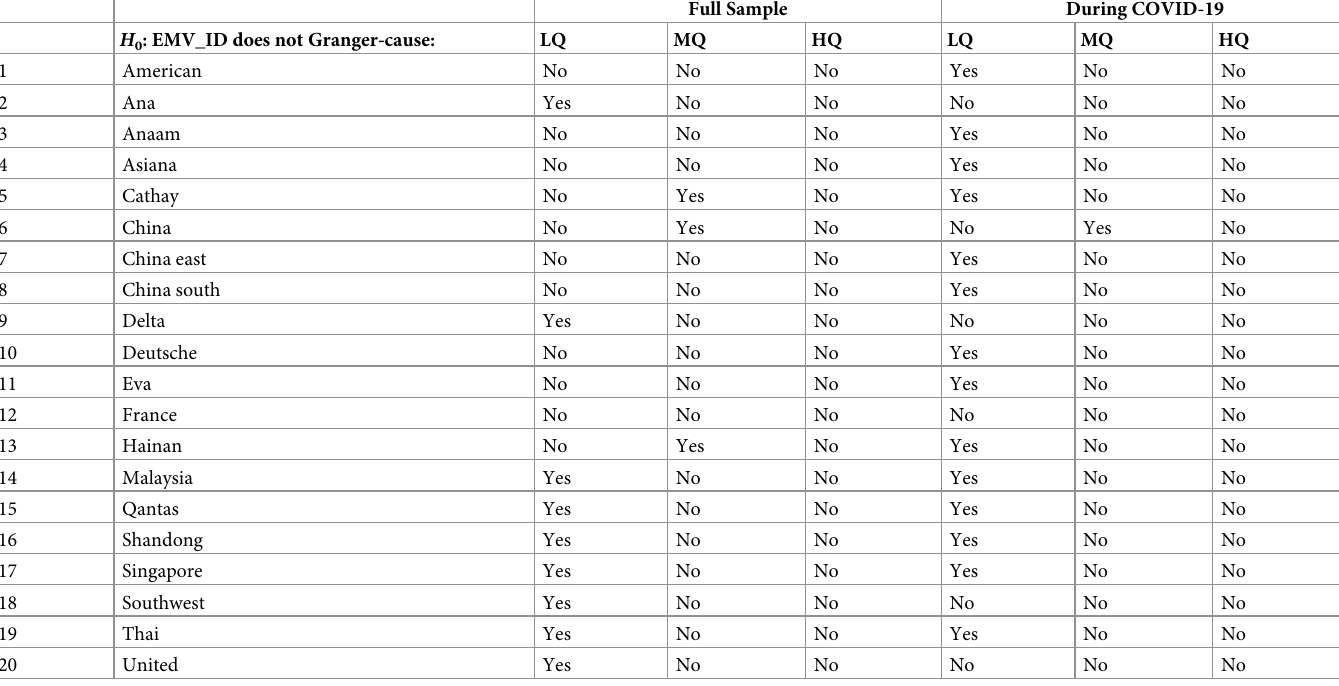
Table 4. Summary of causality in mean (that is, returns) for both full and during COVID-19 samples.